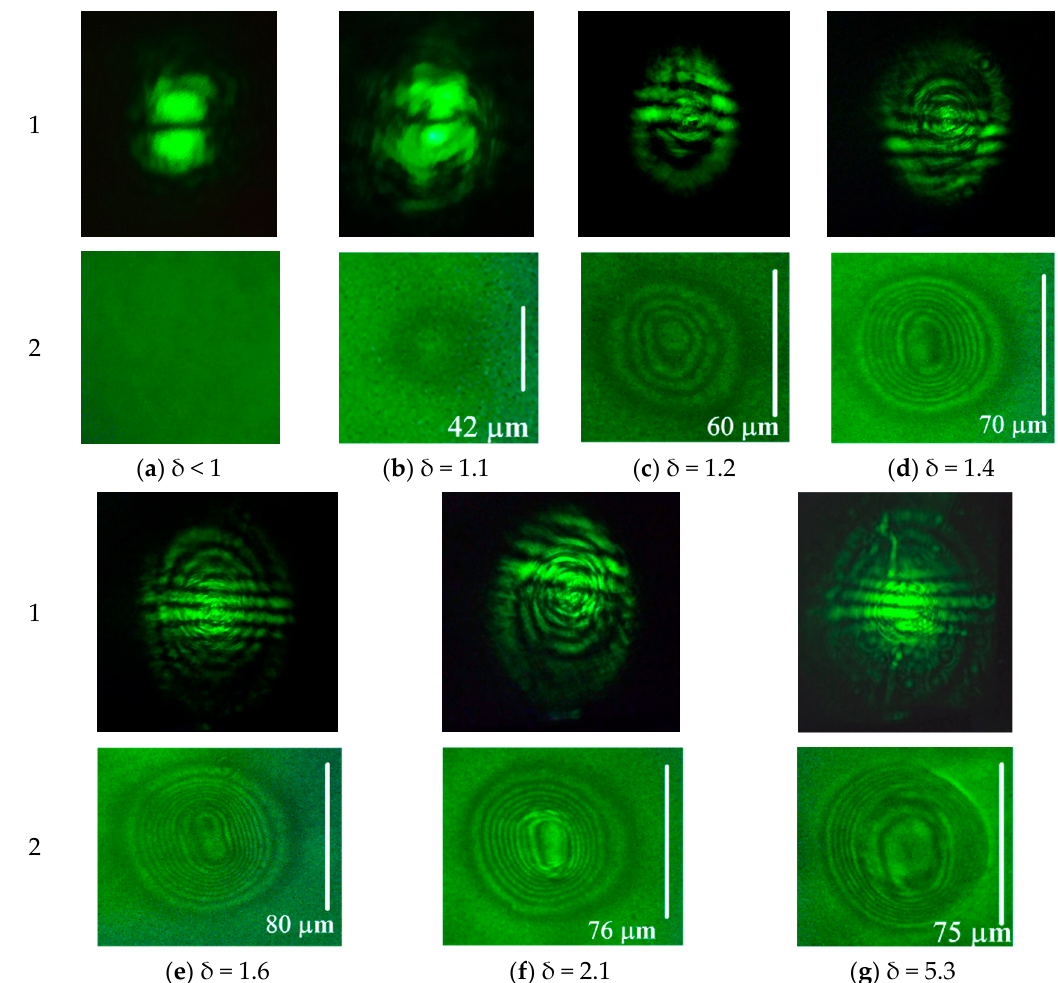
Figure 2. Steady-state aberrational patterns for the normal ( α = 0°) light incidence (row “1”) and corresponding microphotographs (row “2”) obtained at the focal plane for normalized beam power: δ = ( a ) 1, ( b ) 1.1, ( c ) 1.2, ( d ) 1.4, ( e ) 1.6, ( f ) 2.1, and ( g ) 5.3. Aberrational-pattern vertical angular size is ( a ) 0.07, ( b ) 0.09, ( c ), ( d ) 0.54, ( e ) 0.64, ( f ) 0.64, and ( g ) 0.9 rad. Vertical bar indicates the size of the recorded phase structure.